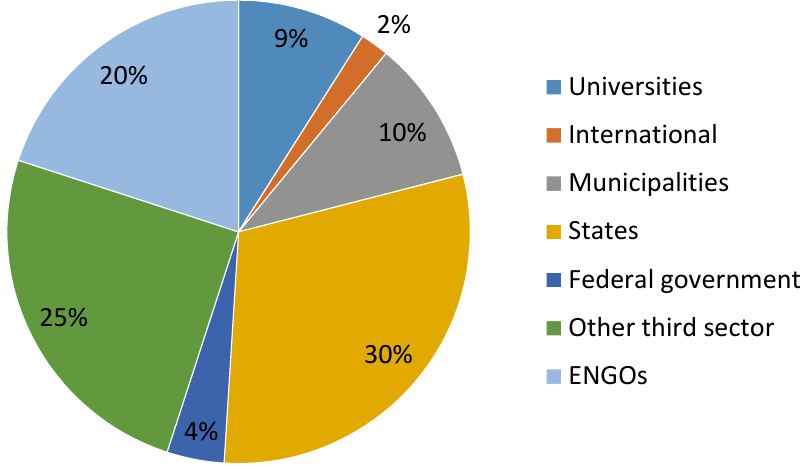
Figure 1. Projects funded by the Amazon Fund categorised according to the nature of the party responsible between 2008 and 2015. Data from BNDES (Brazilian Development